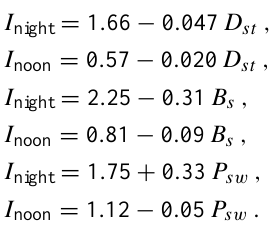
P sw = 3 nPa, B z IMF=0. Figure 6 shows the total electric Figure 6. The same as in Figure 3 but for the model by Tsyganenko (2002a,b).